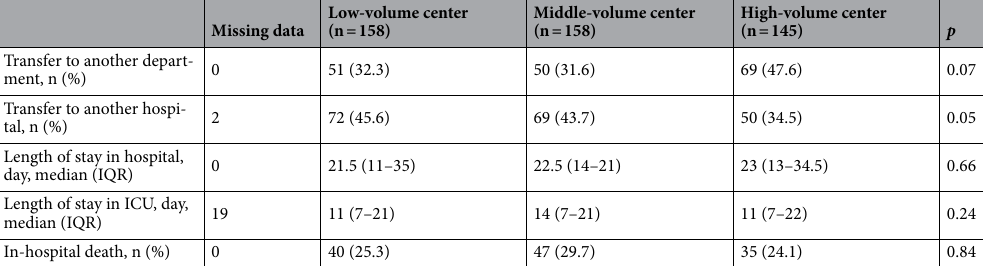
Table 3. Different outcomes among institutions. IQR interquartile range.